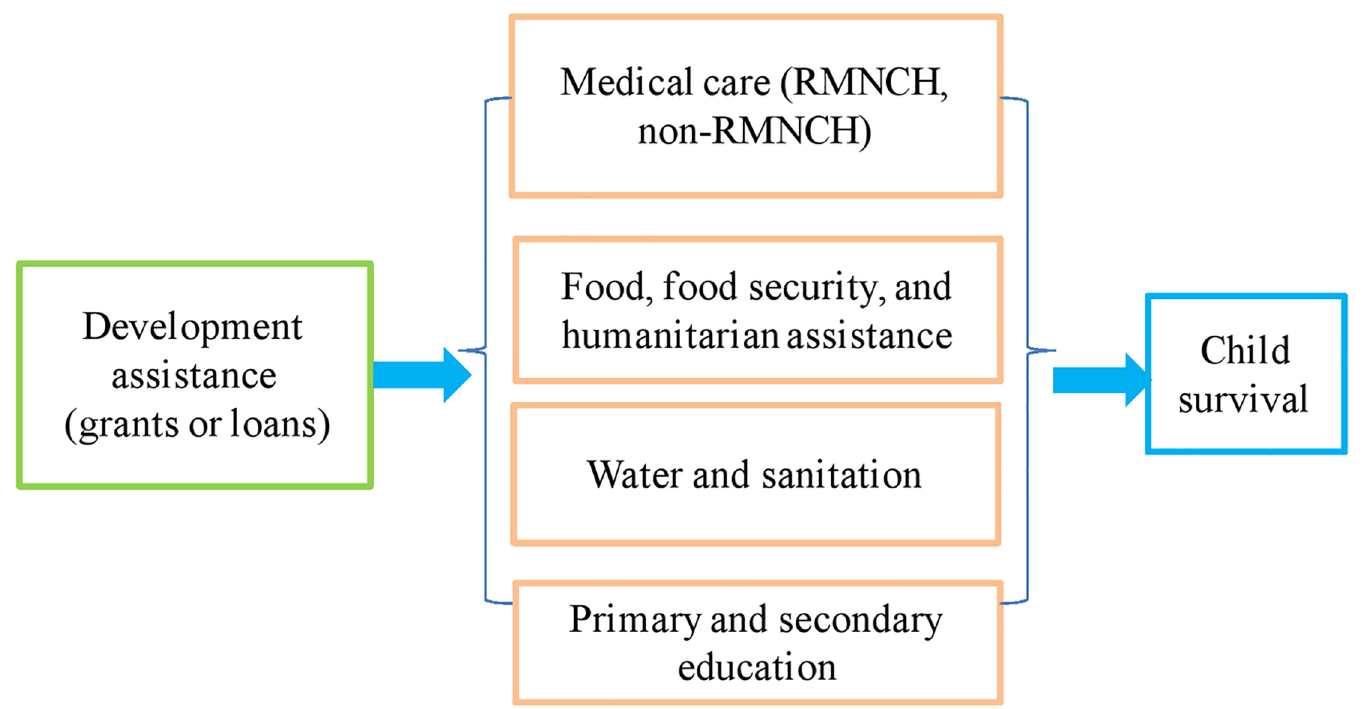
Fig 1. Conceptual framework on defining development assistance for child survival.